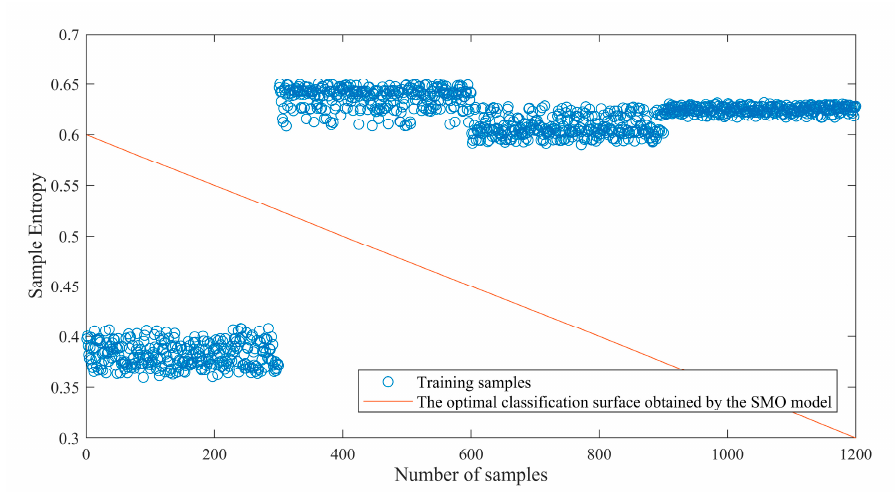
Figure 10. The optimal classification surface of the SMO model.